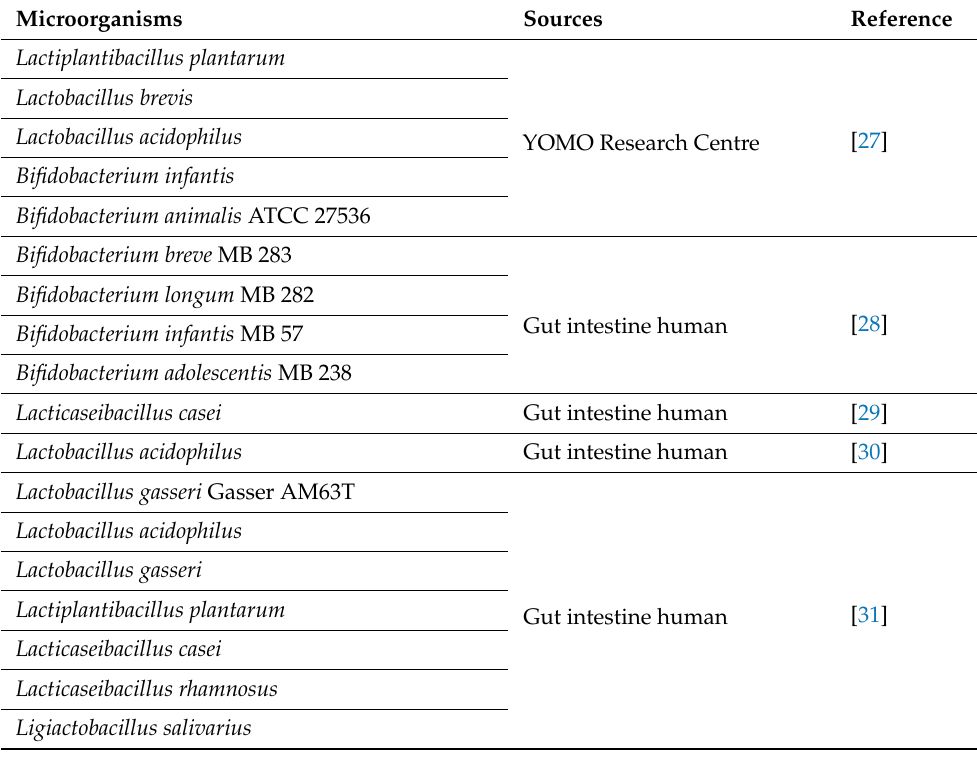
Table 1. Oxalate degrading bacteria in Bifidobacterium and Lactobacillus sp.